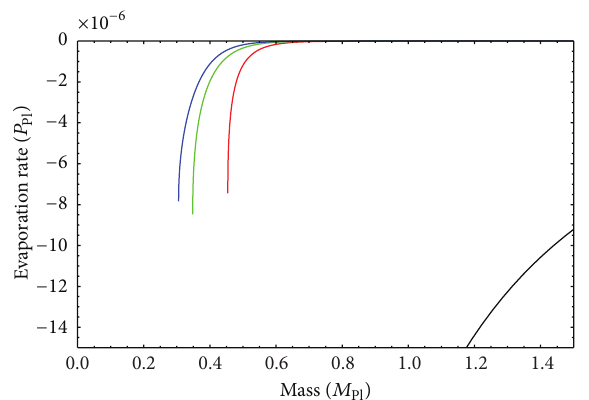
Figure 10: The evaporation rate versus the black hole mass for the case 𝛼 = 1 . Curves are the GUP 𝑛 results for 𝑛 = 2 (red), 𝑛 = 5 (green), and 𝑛 = 10 (blue), respectively, and the Hawking result (black) at the lower right